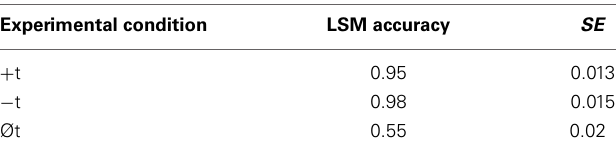
Table 4 | Least Square Means (LSM) of d (cid:2) in the respective